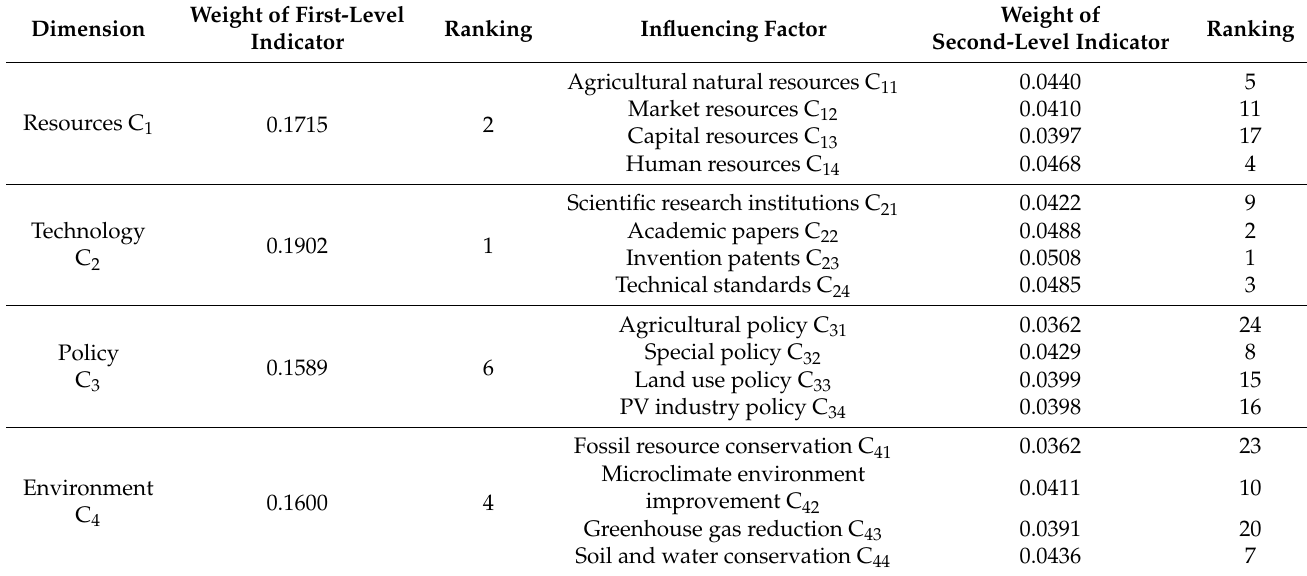
Figure 4. Network relationship diagram of the niche influencing factors. Finally, the DANP method was used to calculate the weight of each influencing factor, as shown in Table 6. Table 6. Weights of factors affecting the niche improvement of photovoltaic